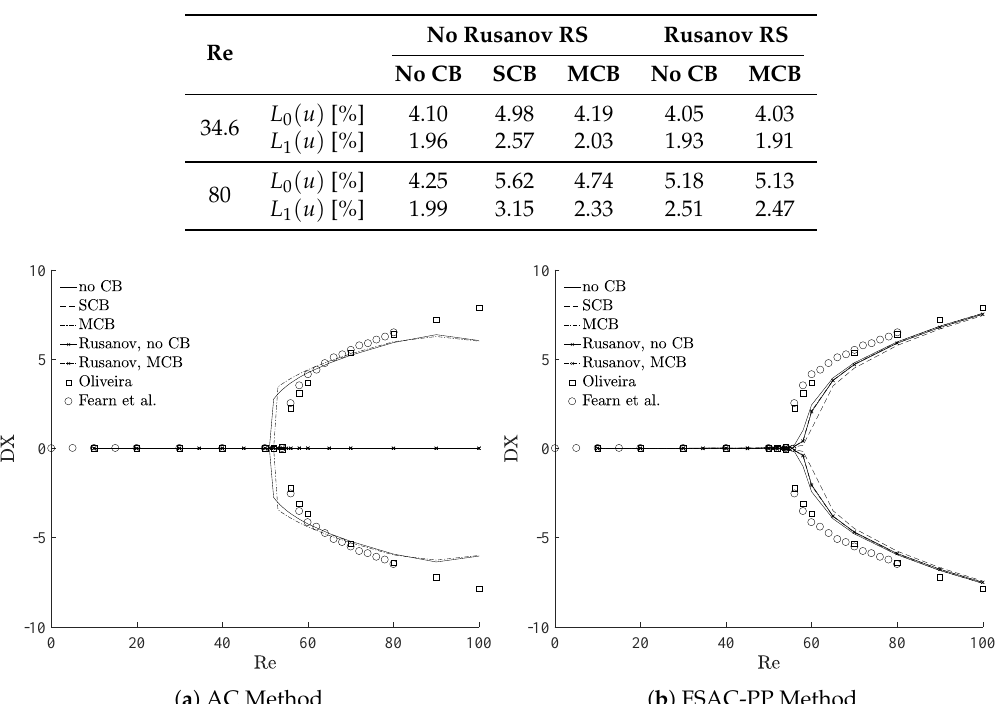
Figure 5. Bifurcation diagram for the AC ( a ) and FSAC-PP ( b ) method using different combinations of CB schemes and the Rusanov Riemann